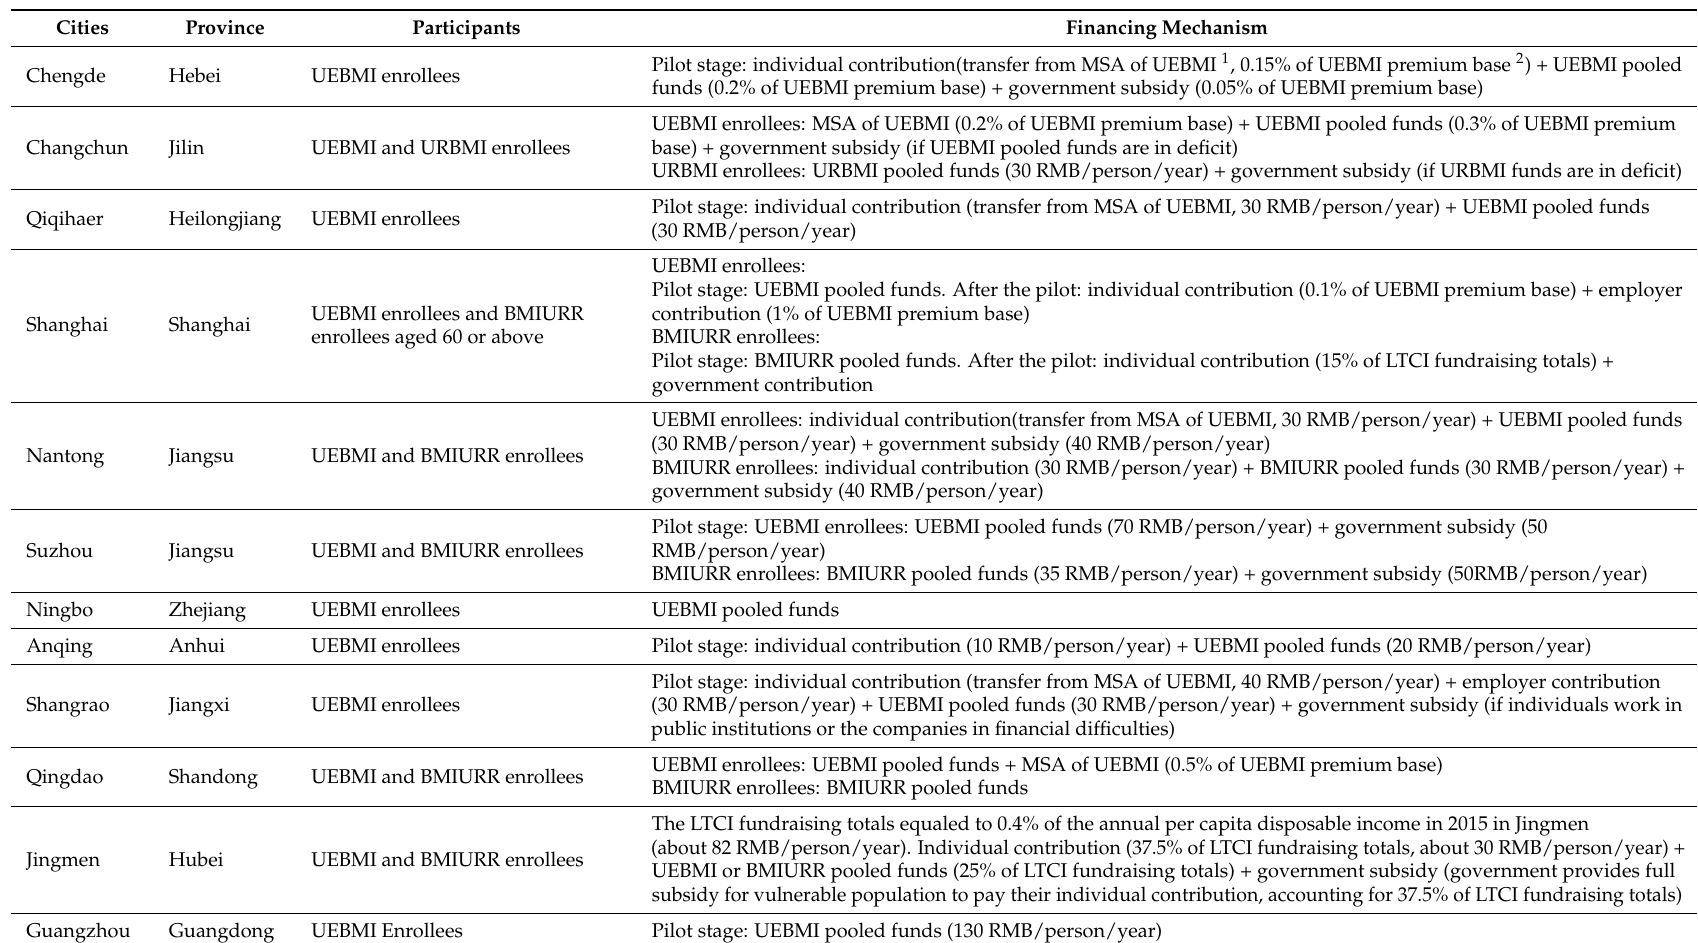
Table A3. Current LTCI policies in the pilot cities in China